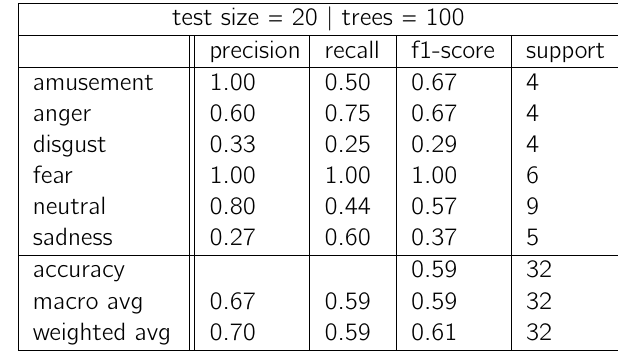
Table 4: Results using the 3 class CWT EDA data with synthetic data. Test size = 20 and trees = 300.